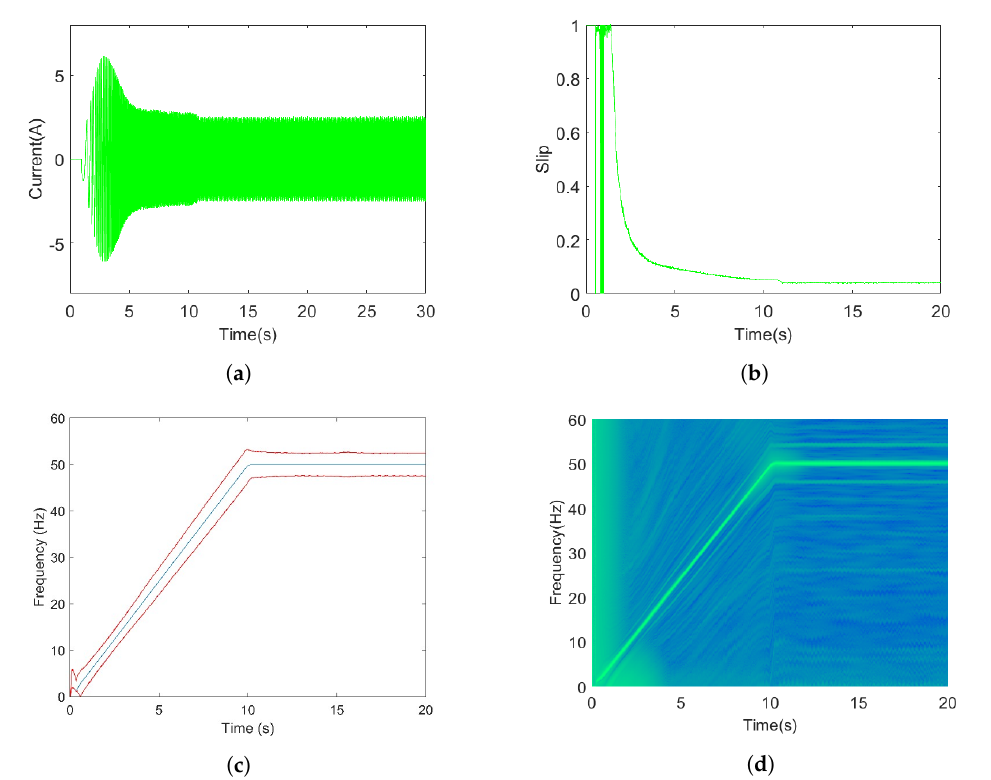
Figure 1. Analysis with the Dragon Transform of the stator current of an inverter-fed induction motor with a broken rotor bar during a linear startup: ( a ) Stator current; ( b ) Motor slip; ( c ) Theoretical trajectories of the first component and the bar breakage harmonics; ( d ) Time-frequency distribution of the stator current given by the Dragon